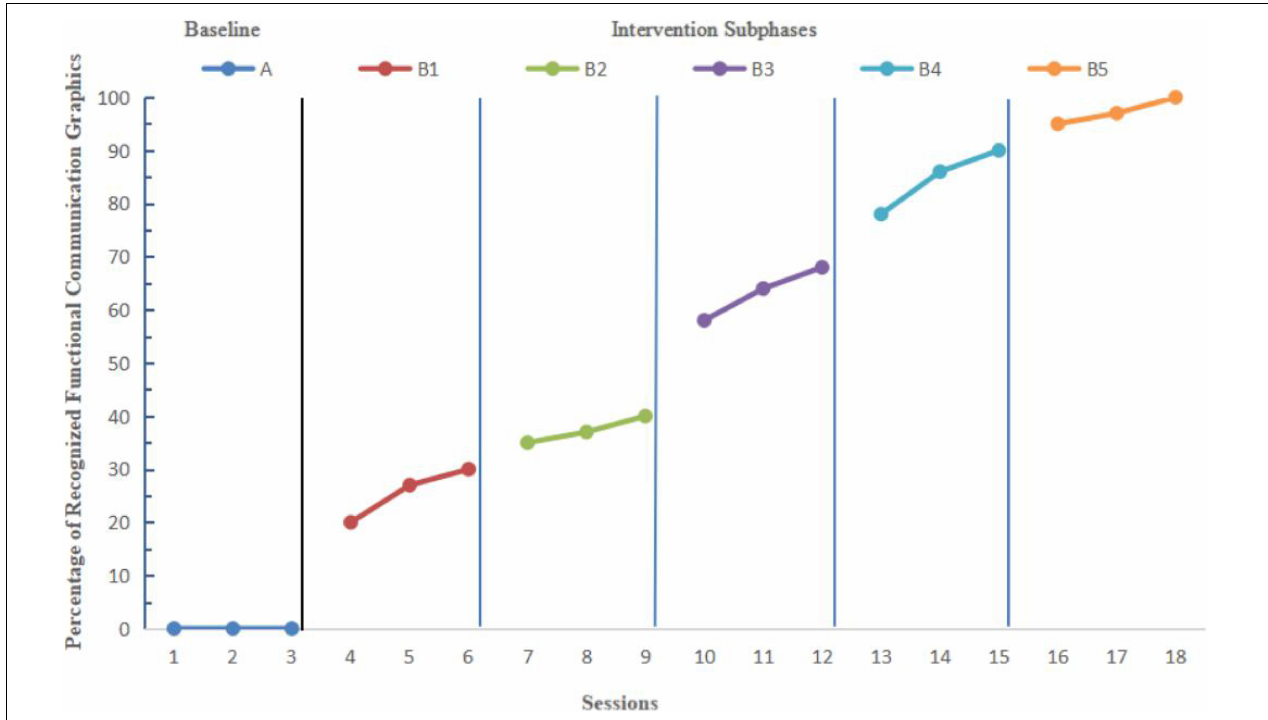
FIGURE 2 | Recognition of functional communication graphics.